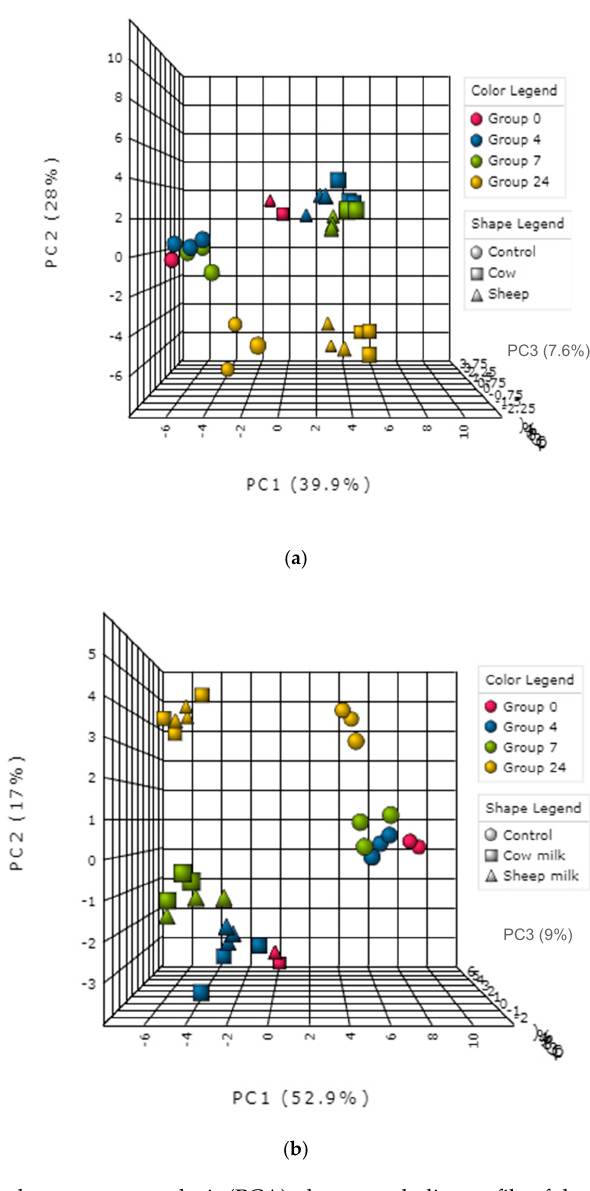
Figure 5. ( a ): Principal component analysis (PCA) plot—metabolite profile of the one-month old’s fecal fermentation, analyzed using NMR metabolomics. ( b ): PCA plot—metabolite profile of the five-month old’s fecal fermentation, analyzed using NMR